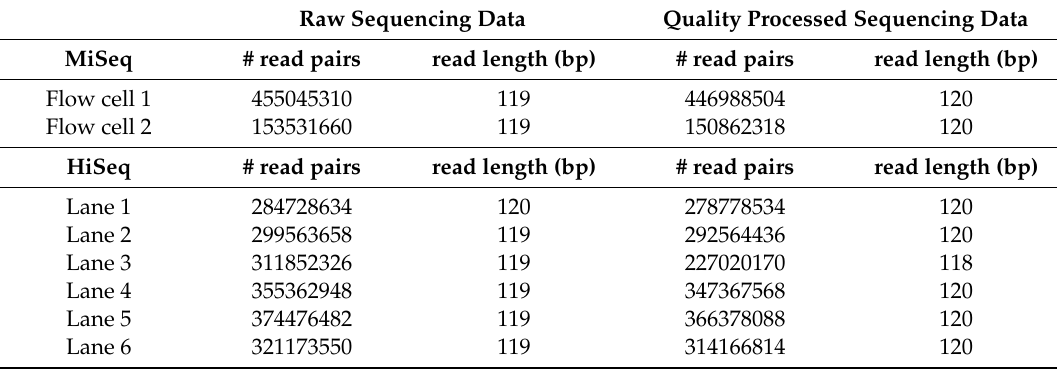
Table 1. Statistics for the Illumina sequencing data from one rooibos genotype.